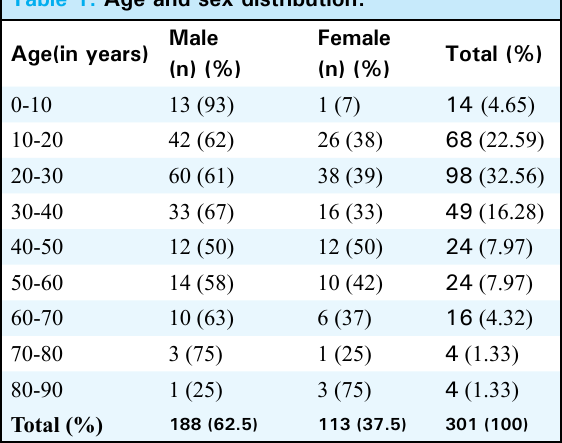
Table 1. Age and sex distribution.